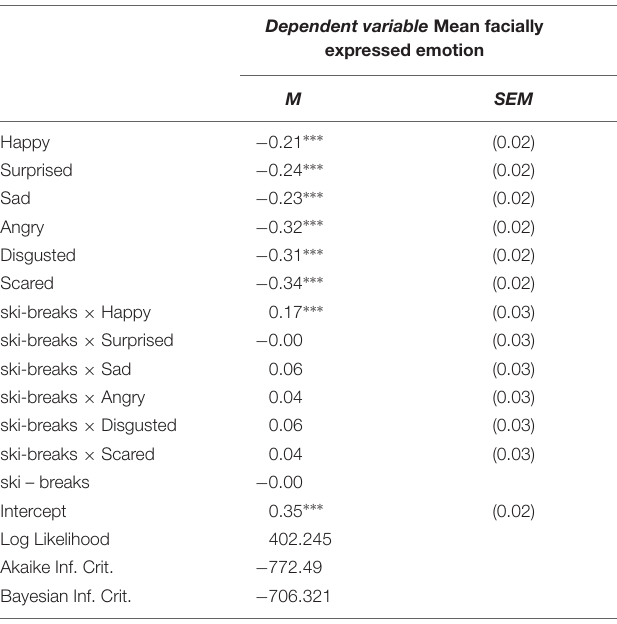
TABLE 2 | Summary of the random intercepts model for mean (M) and standard error of the mean (SEM) and goodness of fits indicators for facially expressed emotions during skiing and